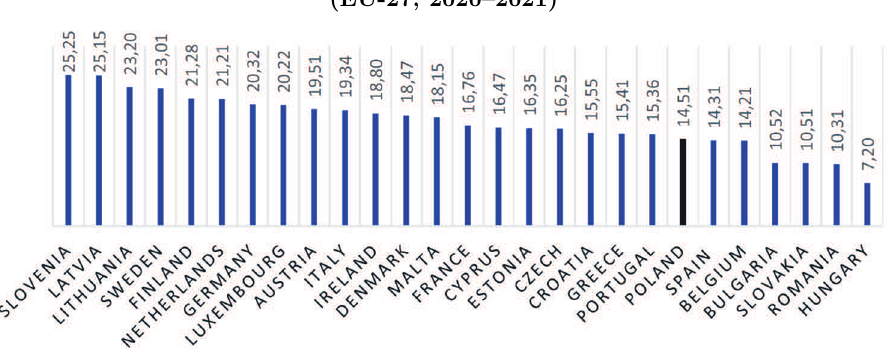
Governments’ fiscal responses to COVID-19 as a percentage of GDP (EU-27; 2020–2021)